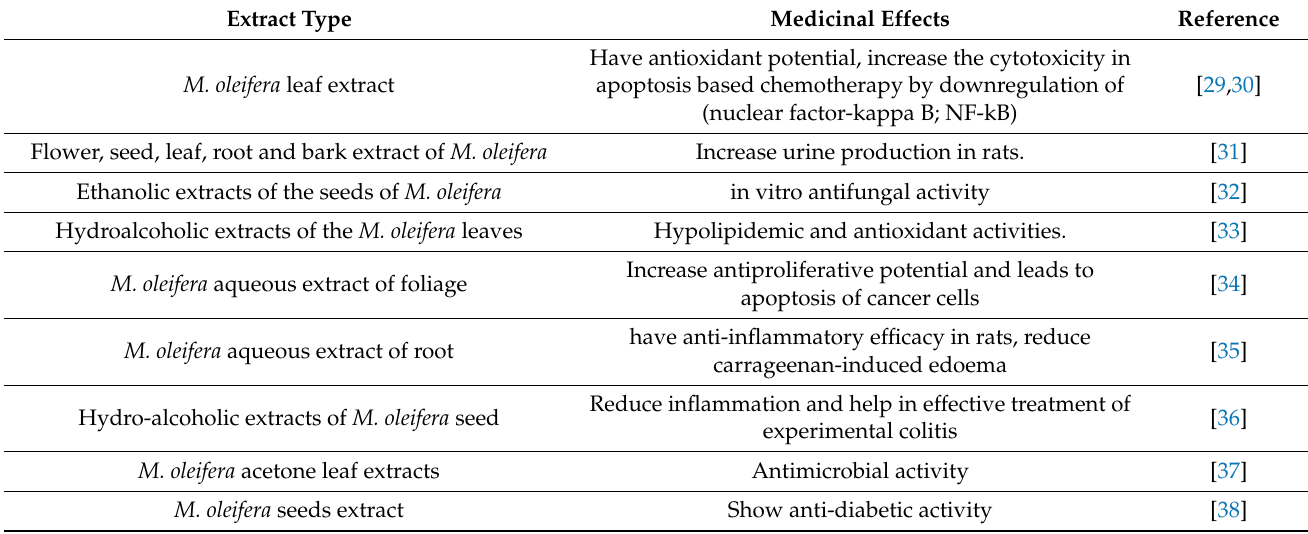
Table 2. Various extracts of Moringa oleifera and their biological